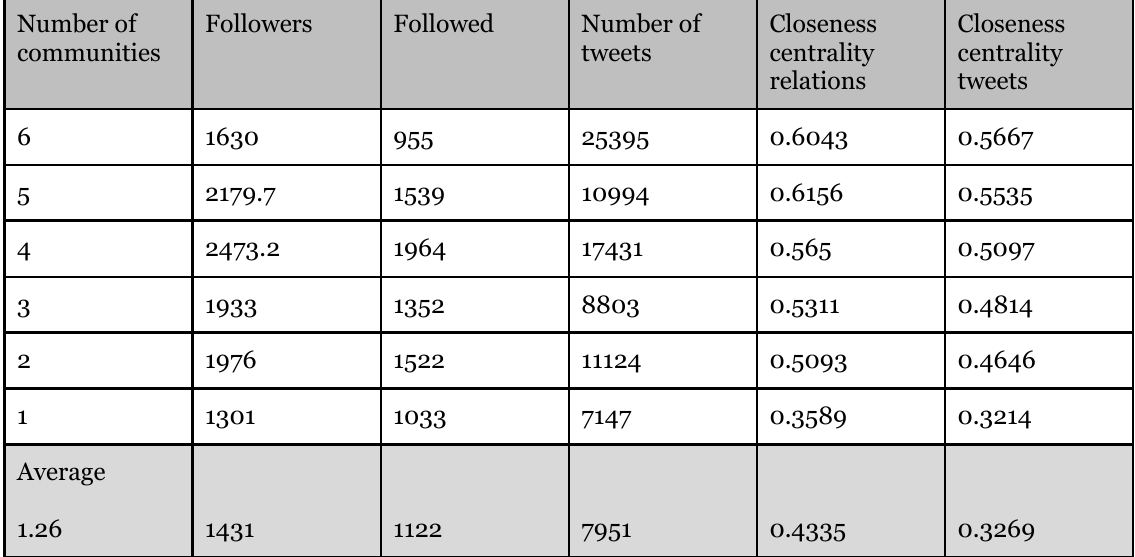
Average Profile of all the Members Classified According to the Number of Communities they Belong to Number of